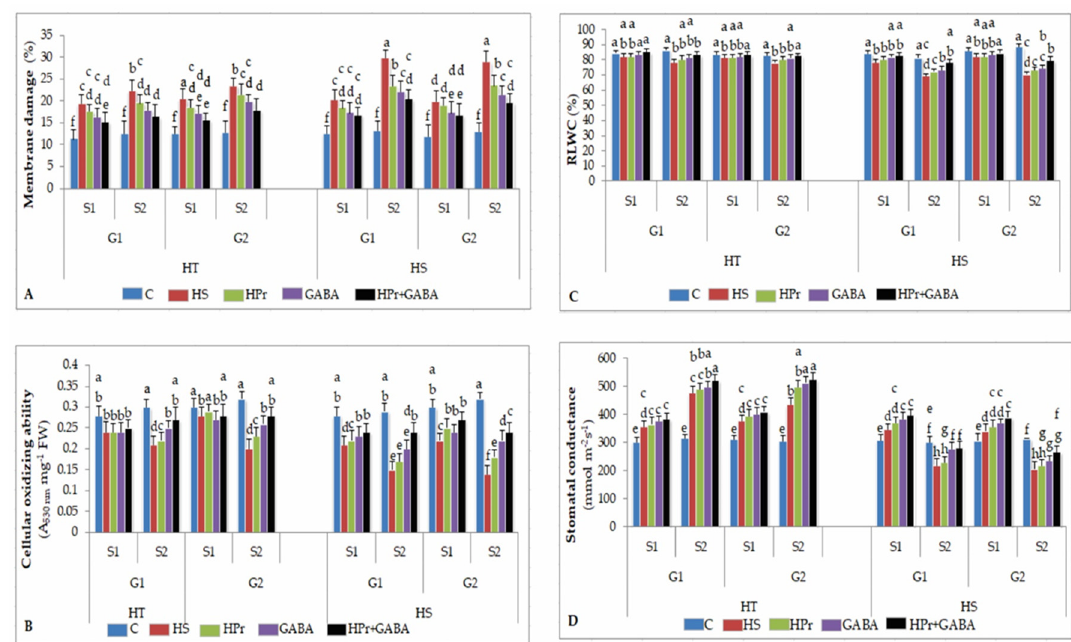
Figure 2. Effect of heat priming (HPr) and γ -amino butyric acid (GABA), applied individually or in combination (HPr+GABA) on membrane damage ( A ), cellular oxidizing ability ( B ), relative leaf water content, RLWC ( C ) and stomatal conductance ( D ) on heat-tolerant (G1: IG2507; G2: IG3263) and heat-sensitive (G1: IG2821; G2: IG2849) genotypes at stage 1 (S1) and stage 2 (S2) in heat-stressed (HS) lentil plants, compared to control ( C ). Vertical bars represent standard errors ( n = 3). Different small letters on the bars indicate significant differences from each other ( p < 0.05). LSD for interaction (genotypes × stages × treatments) ( p < 0.05): membrane damage: 2.9; cellular oxidizing ability: 0.030, relative leaf water content: 2.2, stomatal conductance: 26.3. FW = fresh weight.